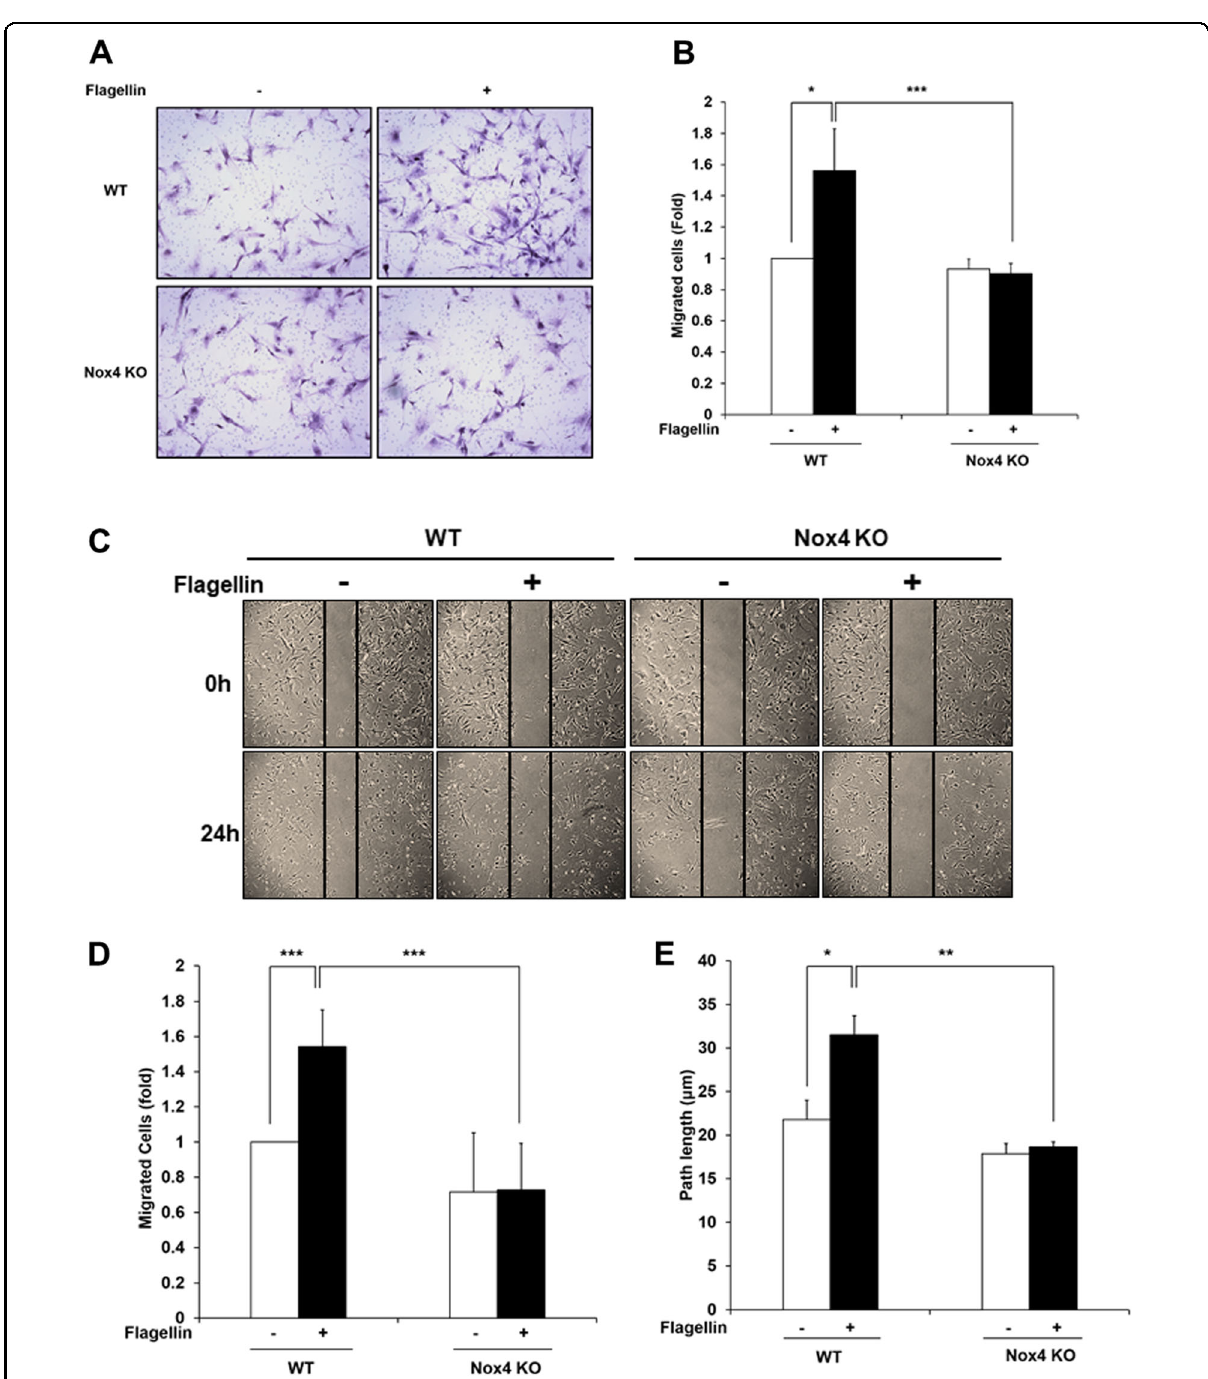
Fig. 4 Nox4 regulates the fl agellin-induced migration of smooth muscle cells. a Transwell migration assay. WT and Nox4 KO SMCs were seeded into the upper chamber, and stimulating medium containing fl agellin (100 ng/mL) was added to the lower chamber. After 16 h, the migrated cells were stained with hematoxylin/eosin and counted. Representative images are shown for each group. b Quanti fi cation of the transwell migration assay results ( N = 5, mean ± SD, * p < 0.05, *** p < 0.001). c Wound healing assay. After WT and Nox4 KO SMCs (initial cell number: 1 × 10 5 cells) reached 90% con fl uence, the cells were serum-starved for 4 h and then pretreated with mitomycin C (5 μ g/mL) for 1 h. The SMCs were subjected to injury by scratching and then incubated with or without fl agellin (100 ng/mL) for 24 h. d The migrated cells in the wound healing assay were quanti fi ed ( N = 5, mean ± SD, *** p < 0.001). e The path length of the migrating cells after 4 h is presented as the mean ± SD from three independent experiments ( n = 9 cells). ** p < 0.01 (Student ’ s t-